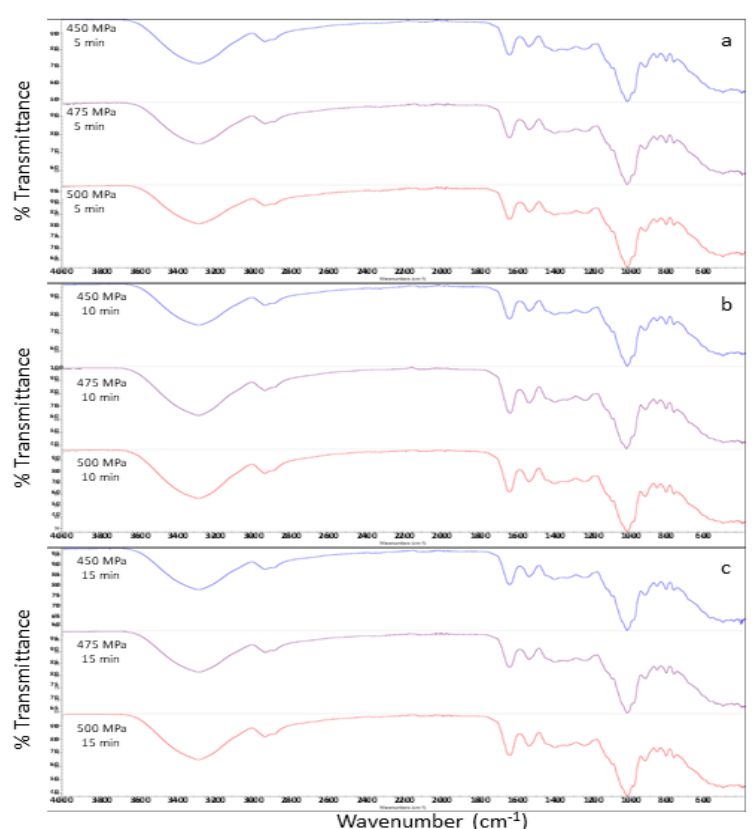
Figure 5. Effect of high-pressure and time on the FTIR spectra of strawberry-flavoured egg-white pudding. ( a – c ) is FTIR stack spectra of treated with 450–500 MPa for 5, 10, 15 min, respectively .